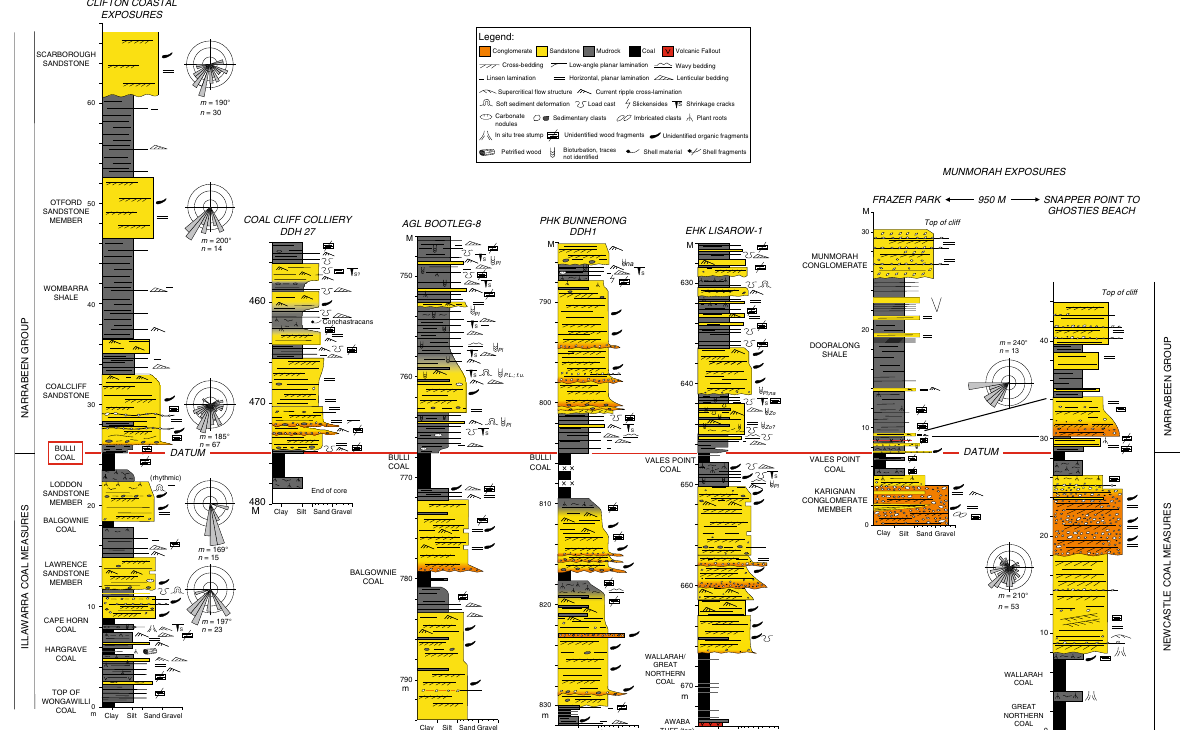
Fig. 3 Graphic logs of the Permo-Triassic boundary interval. Several outcrop sections and drillcores across the Sydney Basin (Fig. 1) are shown, illustrating continuity in sediment body character and stacking patterns (grain size, sandstone body thickness, sedimentary structures, facies relationships) and in sediment dispersal directions, across the putative EPE horizon (red line, which is the horizontal datum for the section). Key to symbols used is also